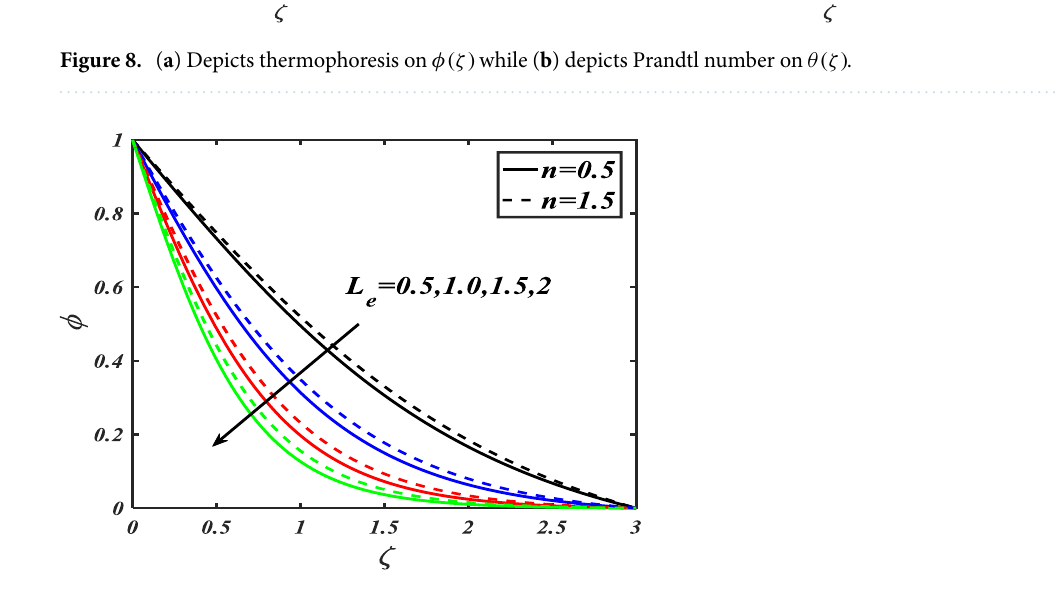
Figure 9. Depicts the effect of Lewis number on φ(ζ)